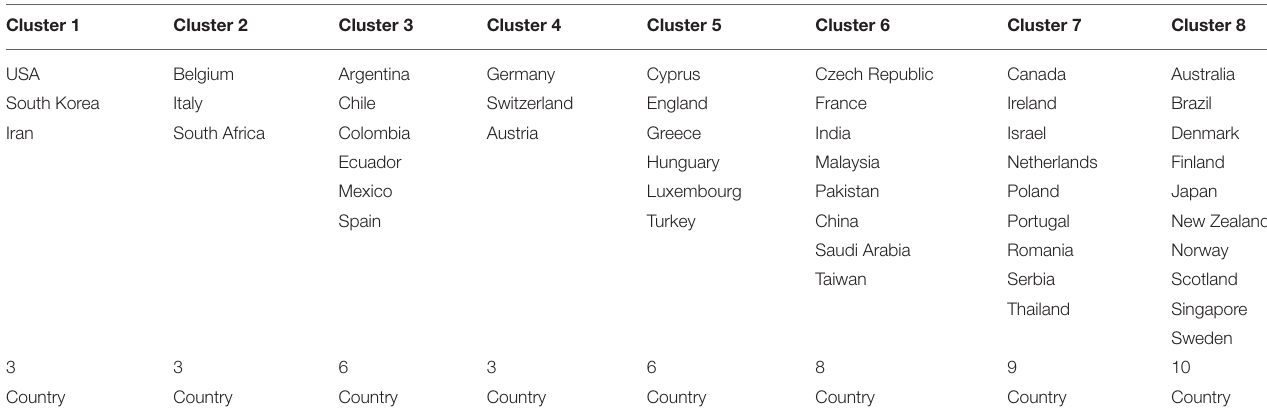
TABLE 1 | Cross-country cooperation